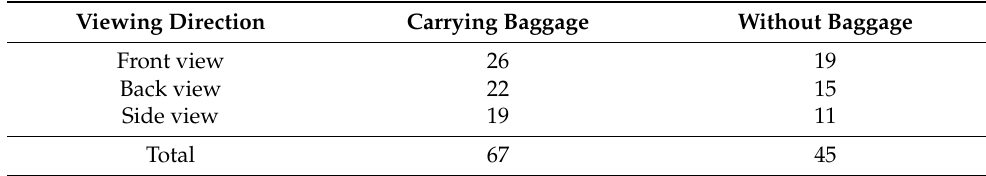
Table 2. INRA dataset distribution.